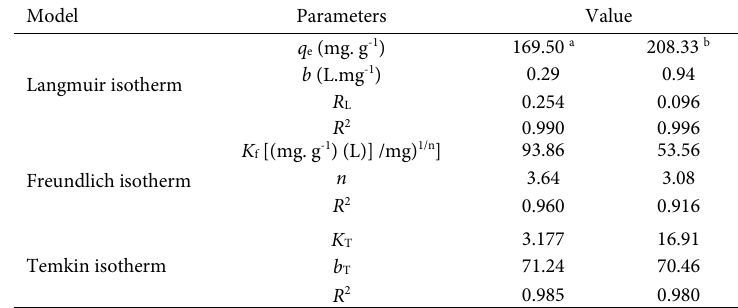
Table 2: Langmuir, Freundlich and Temkin parameters for MB adsorption on Fe 3 O 4 (a) and Fe 3 O 4 /C (b) at 298 K.